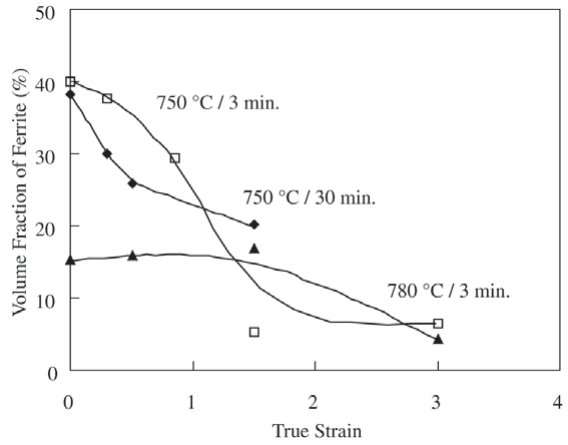
Figure 9. Evolution of the volume fraction of ferrite with defor- mation in the samples strained at 750 °C (3 and 30 min) and at 780 °C (3